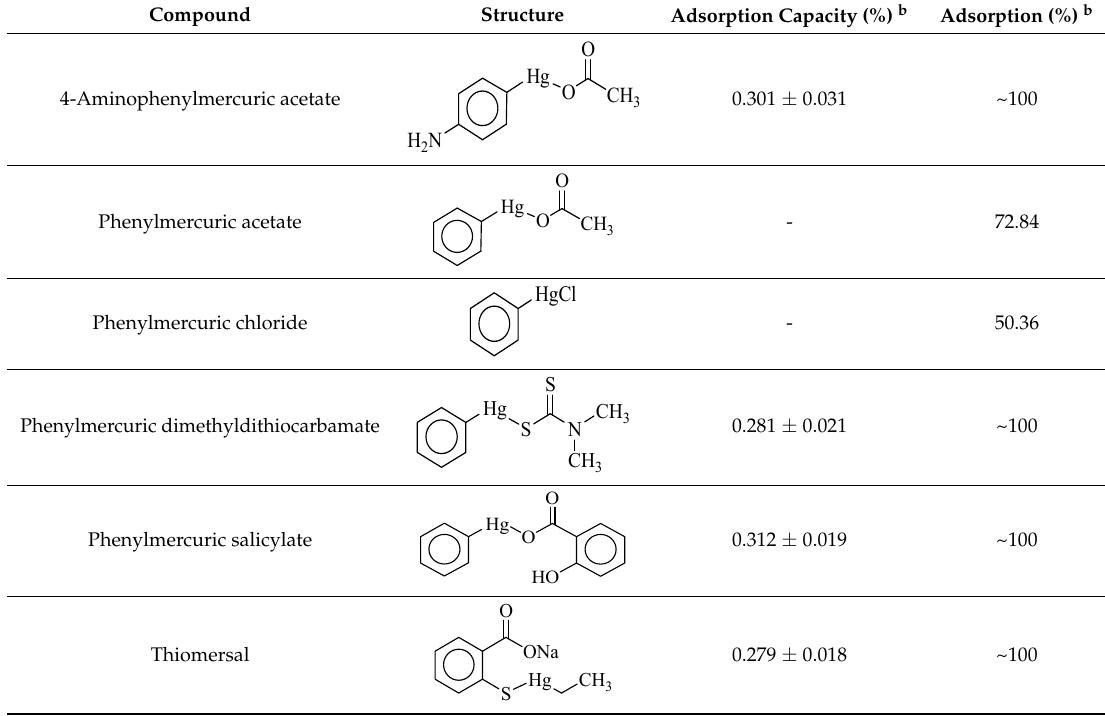
Table 1. The percentage of adsorption and selected adsorption capacity for six different phenylmercuric compounds with lignin-immobilized silica gel as the adsorbent in chloroform a . Compound Structure